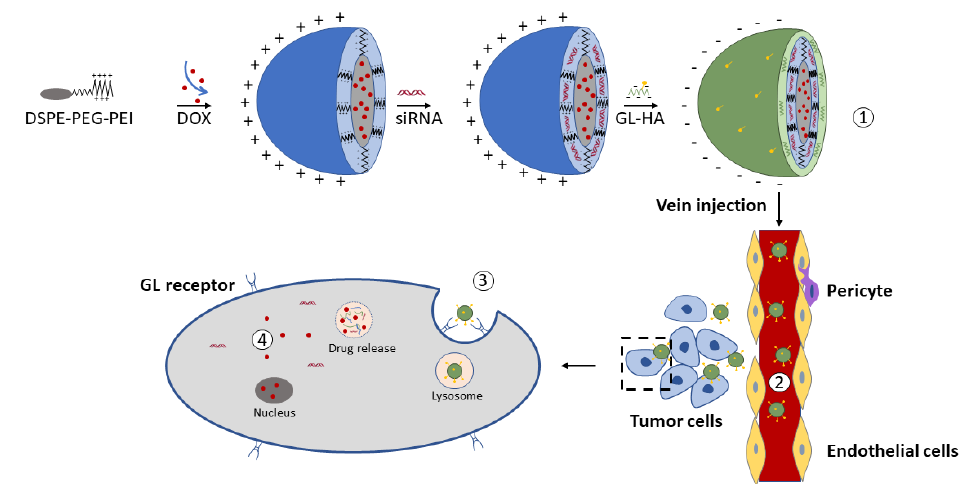
Figure 5. Schematic representation of ( 1 ) siRNA/DOX/GH-DPP-NPs preparation, ( 2 ) distribution of drugs vectorized to the liver by the blood cycle, ( 3 ) cell uptake, and ( 4 ) Bcl-2 siRNA and DOX release ph-triggered. Desaturated from [102], Frontiers, 2019.